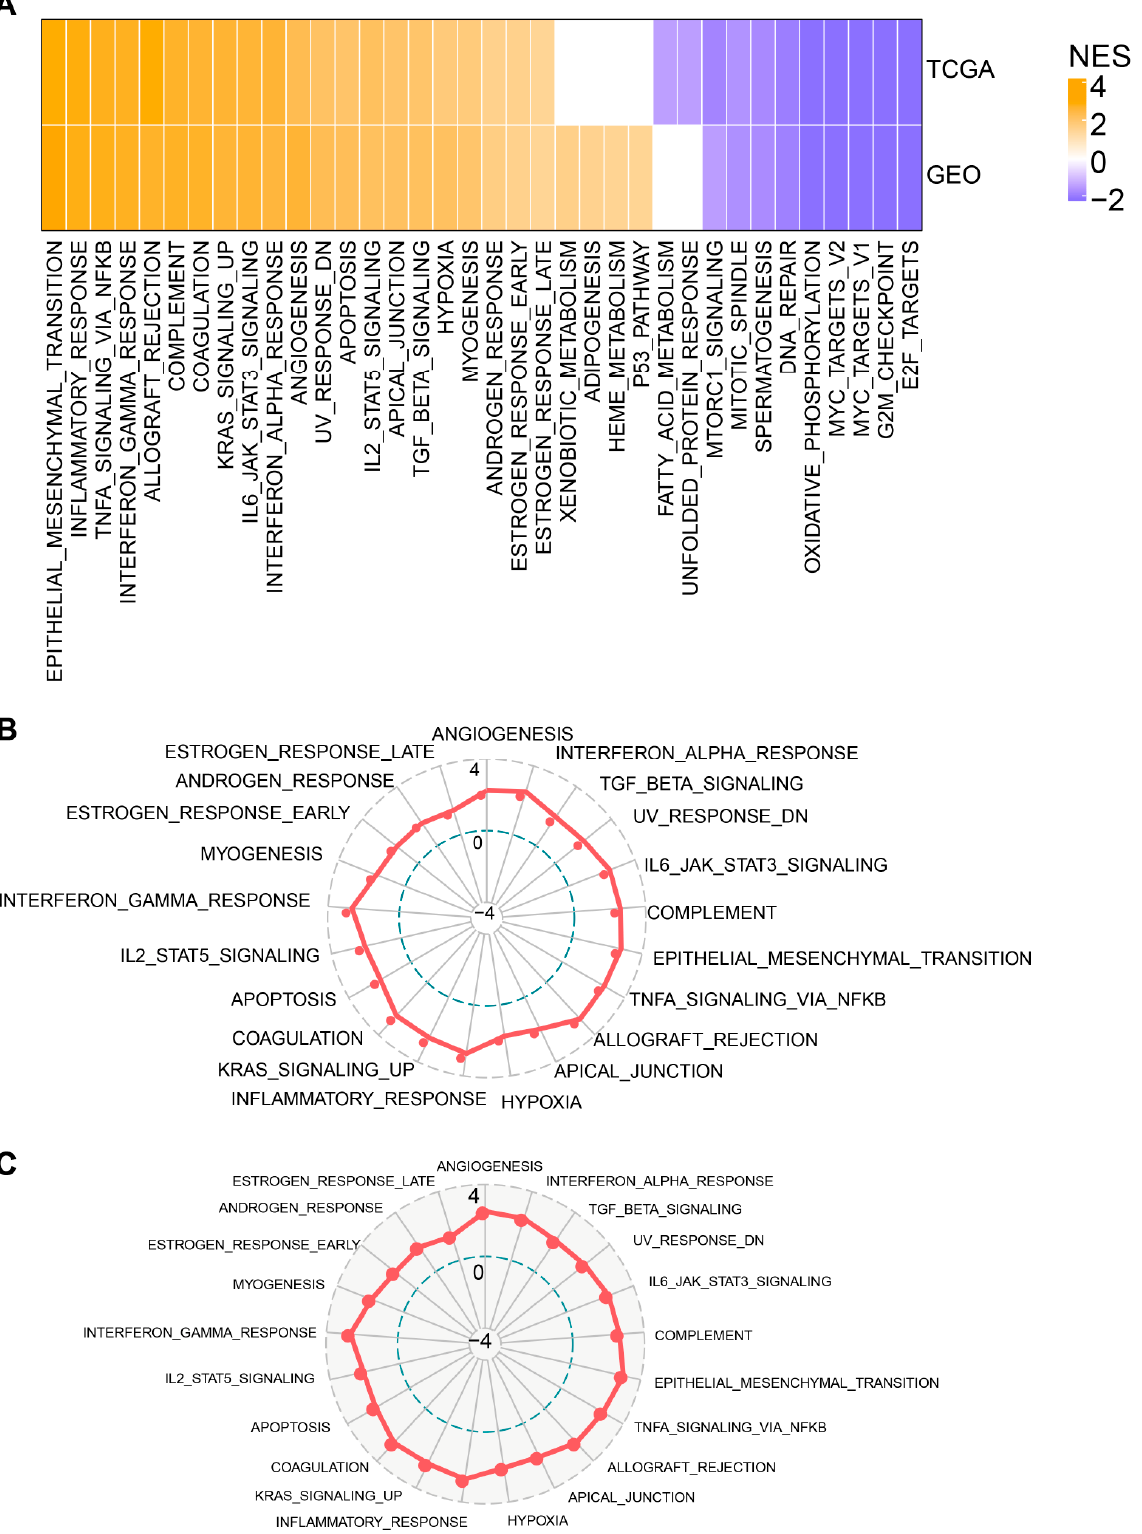
Figure 4. Signaling pathway analysis of the EMT-associated lncRNAs subgroup. ( A ) Heatmap demonstrating normalized enrichment scores (NESs) of Hallmark pathways calculated by comparing cluster 2 with cluster 1 (with a false discovery rate (FDR) of <0.05). Radar plots indicating NESs of Hallmark pathways calculated through a gene set enrichment analysis (GSEA) of cluster 1 versus cluster 2 in the TCGA cohort ( B ) and GEO cohort ( C